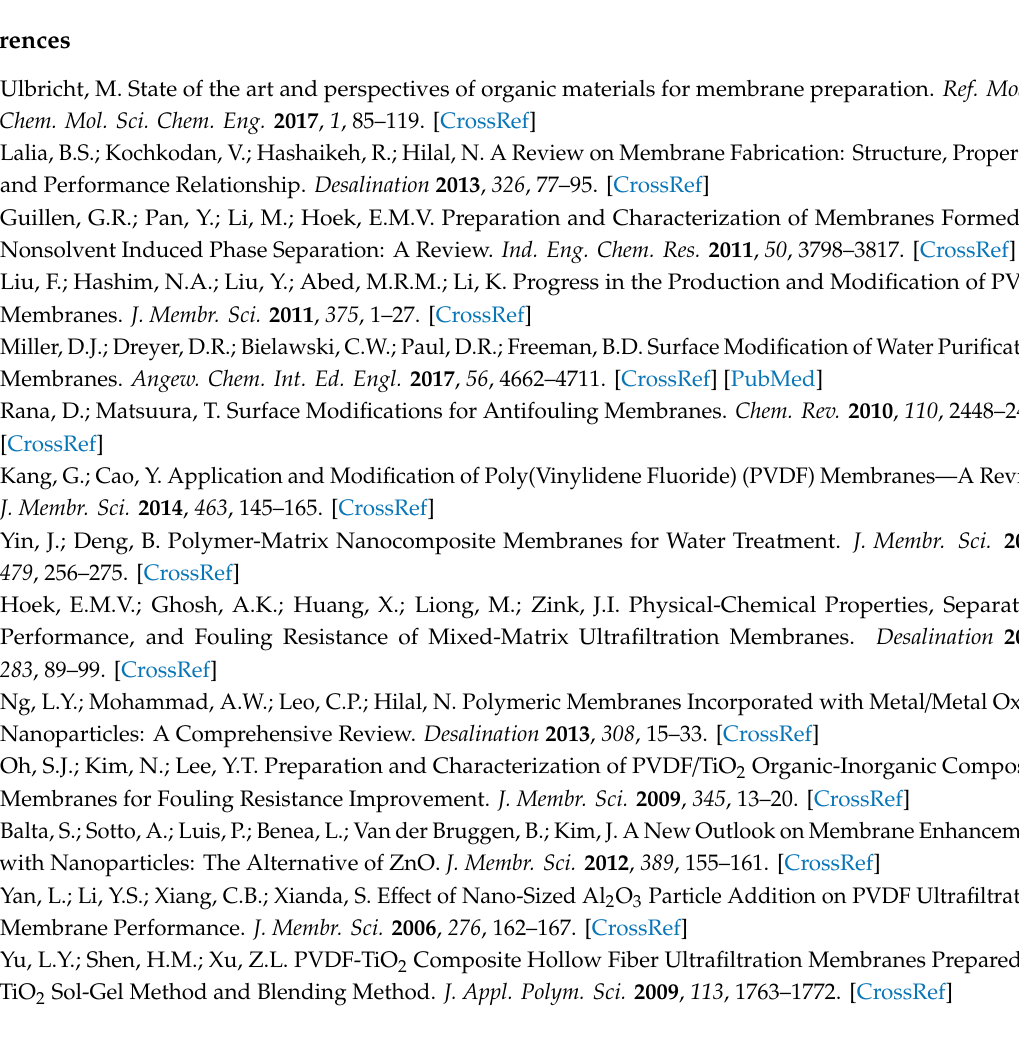
Table S1. Overview of cited studies on nanocomposite ultrafiltration membranes; Table S2. Overview of materials used in this study; Figure S1. E ff ect of ZnO nanoparticle fraction onto viscosity of PVDF solutions in NMP obtained with (reference) and without sonication (“agglomerated”). Figure S2. Viscosity of dope solutions (16% PVDF in NMP); Table S3. Calculated PVP concentration in the dope solutions from Figure S2; Figure S3. Comparison of the viscosity e ff ect of PVP, pristine ZnO particles and ZnO-PVP particles with calculated viscosity increase for ZnO-PVP; Table S4. Membrane performance data; Figure S4. Cross-sections morphology of PVDF membranes obtained from dope solutions (20% PVDF and 1% PVP in NMP) precipitated in coagulation bath consisting of a 50 / 50% v / v mixture of NMP and water, without and with 50% w / w (PVDF) zinc